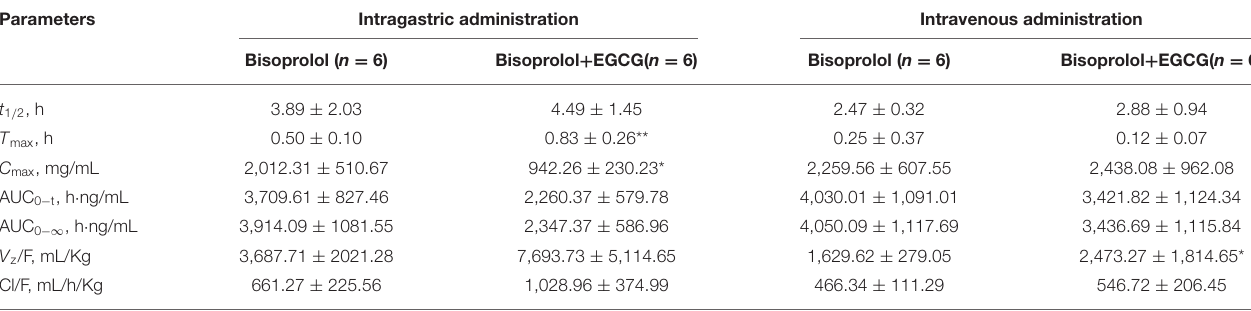
TABLE 5 | Effect of EGCG on the pharmacokinetic parameters of bisoprolol in SD rats. Parameters